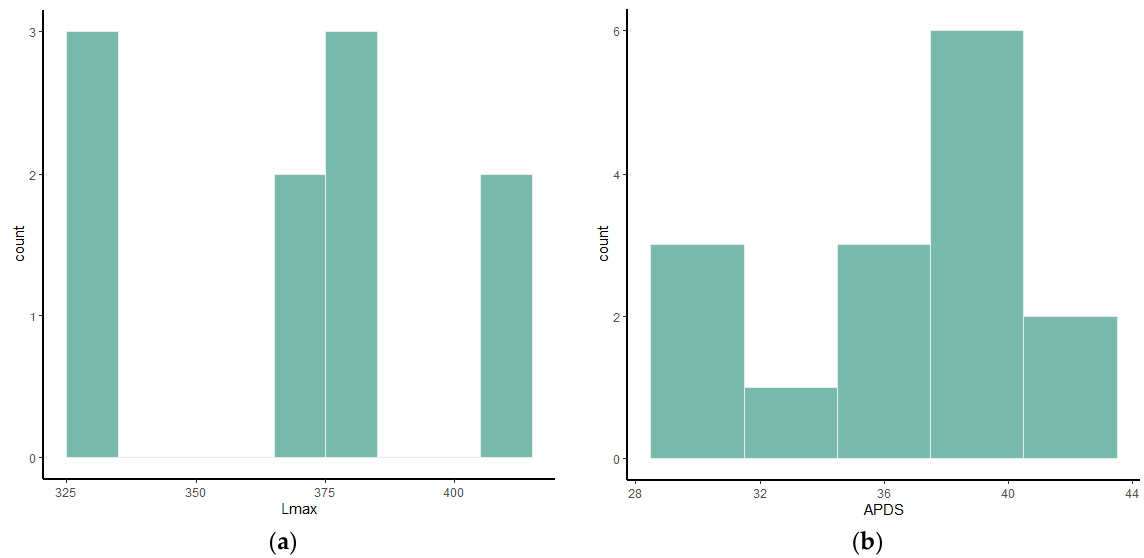
Figure 1. ( a ) Frequency distribution of the maximum length (Lmax) and ( b ) the anterior–posterior diameter of the shaft in the radius of S. etruscus.